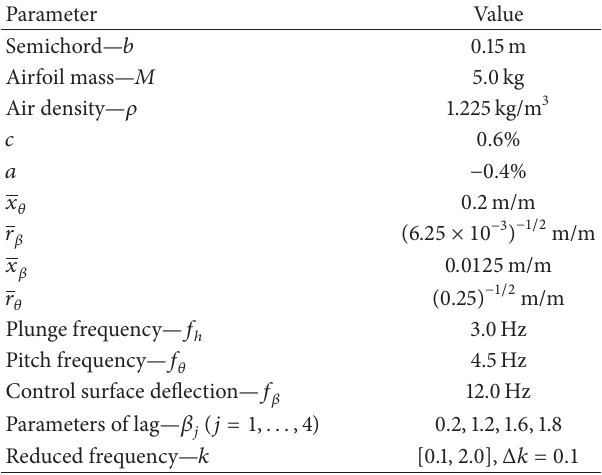
Table 1: Physical and geometric properties of the 2D